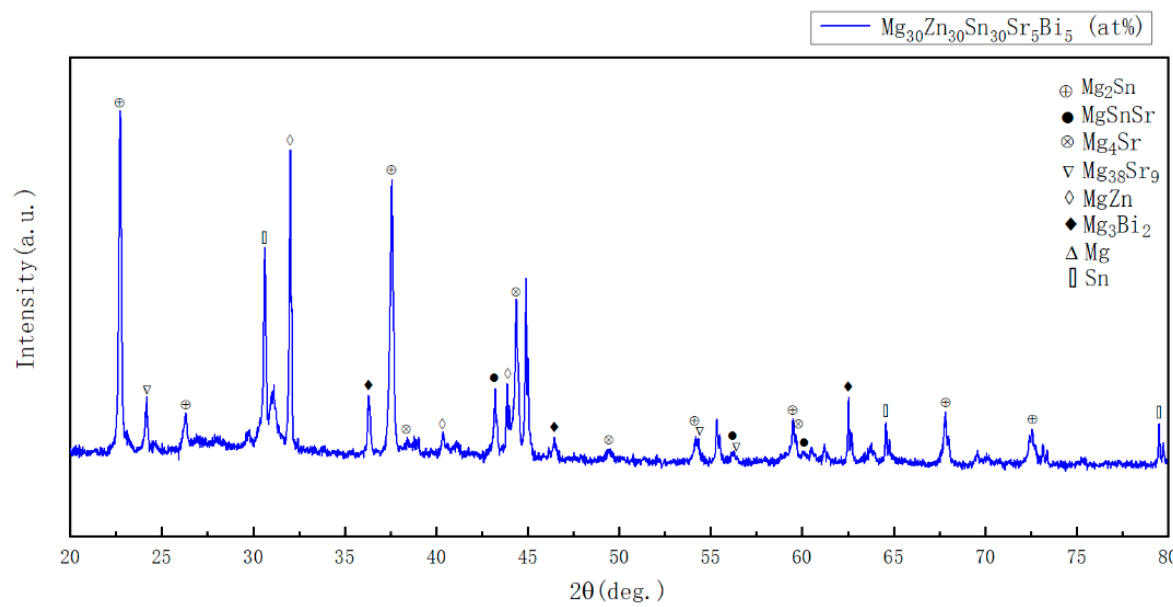
Figure 8. The XRD patterns of the as-cast Mg 30 Zn 30 Sn 30 Sr 5 Bi 5 alloy.